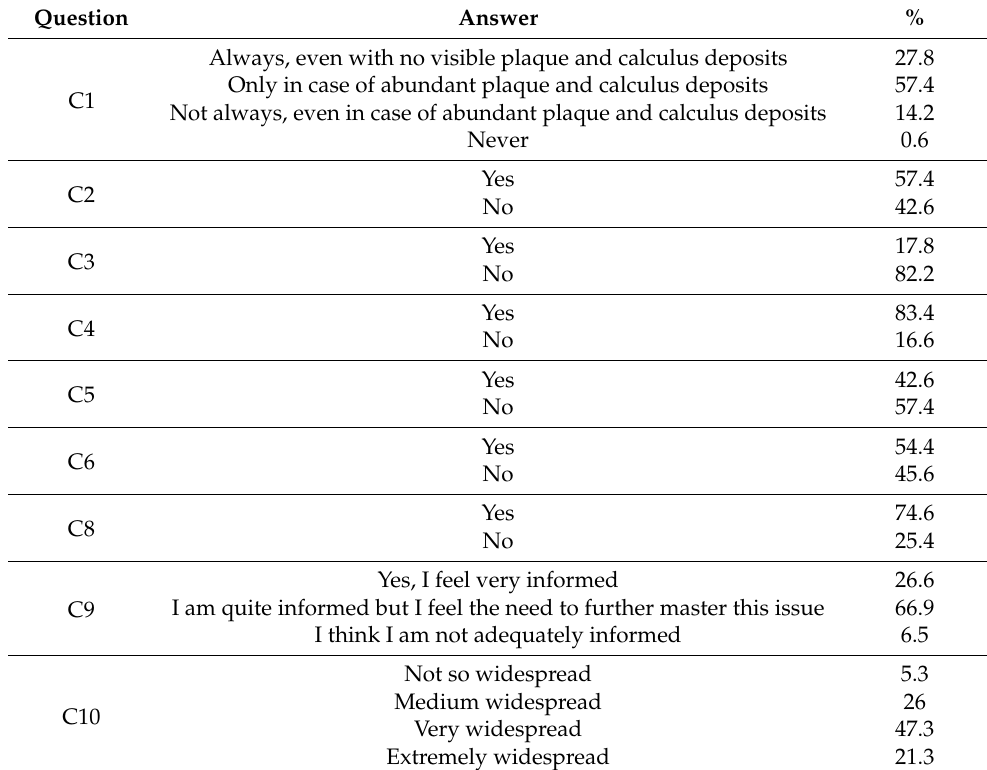
Table 2. Responses to questions about the use of antibiotics in specific clinical scenarios and antibiotic resistance awareness. Percentages are rounded to the first decimal place. Questions are reported in Figure